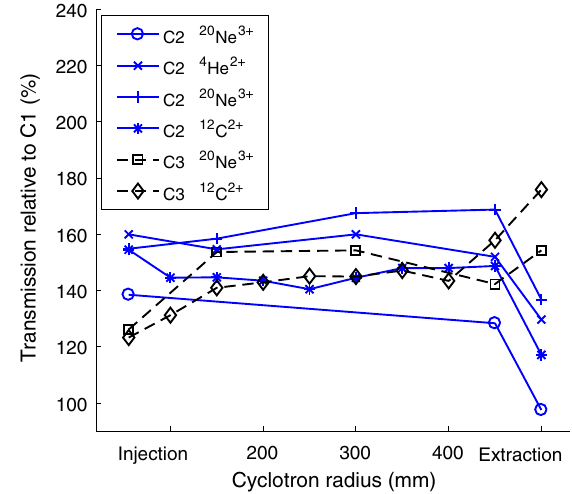
FIG. 13. The transmission of C2 and C3, as a percentage of C1 transmission, with the buncher active. The relative transmission of C3 increases when the buncher is activated, while that of C2